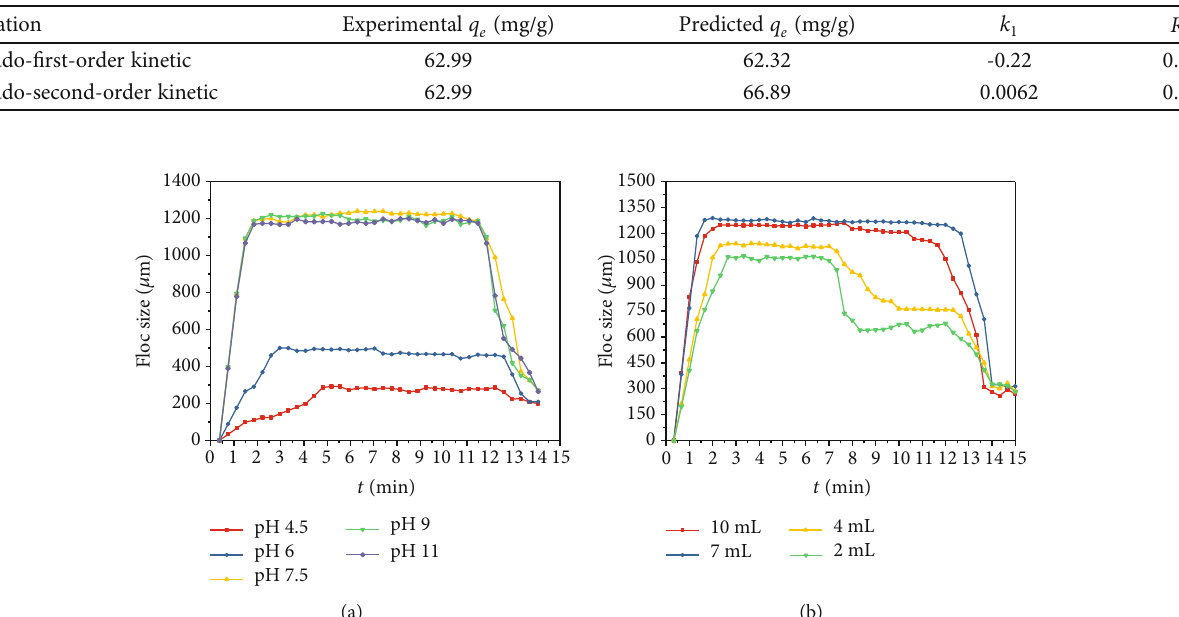
Figure 4: The e ff ect of factors on fl oc formation: (a) pH and (b) dosage of